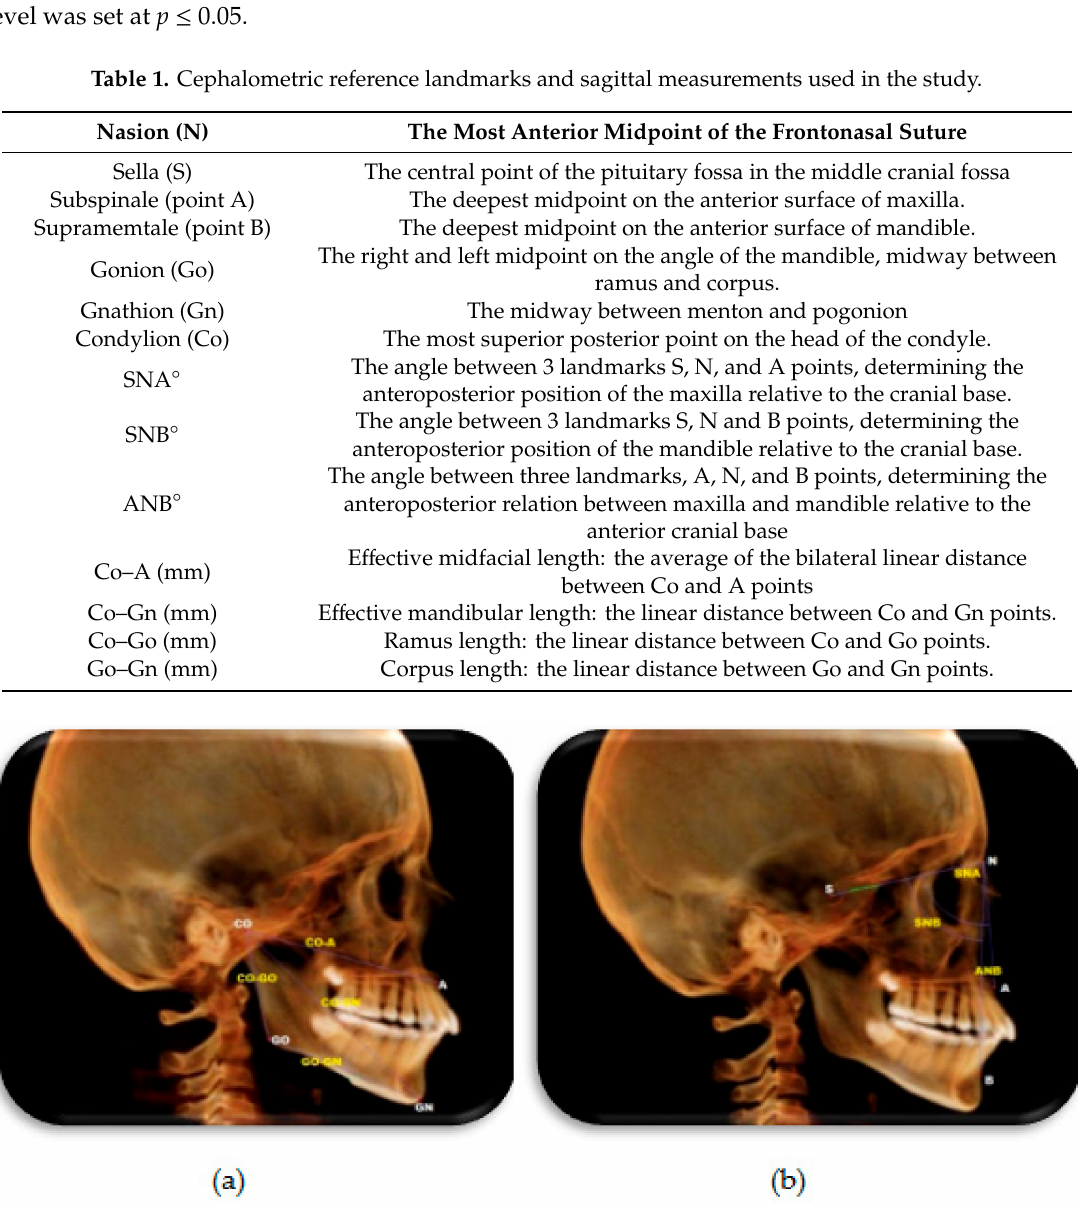
Figure 7. Constructed lateral cephalometric radiograph showing skeletal landmarks and measurements used in the study. ( a ) Sagittal measurements. ( b ) Angular